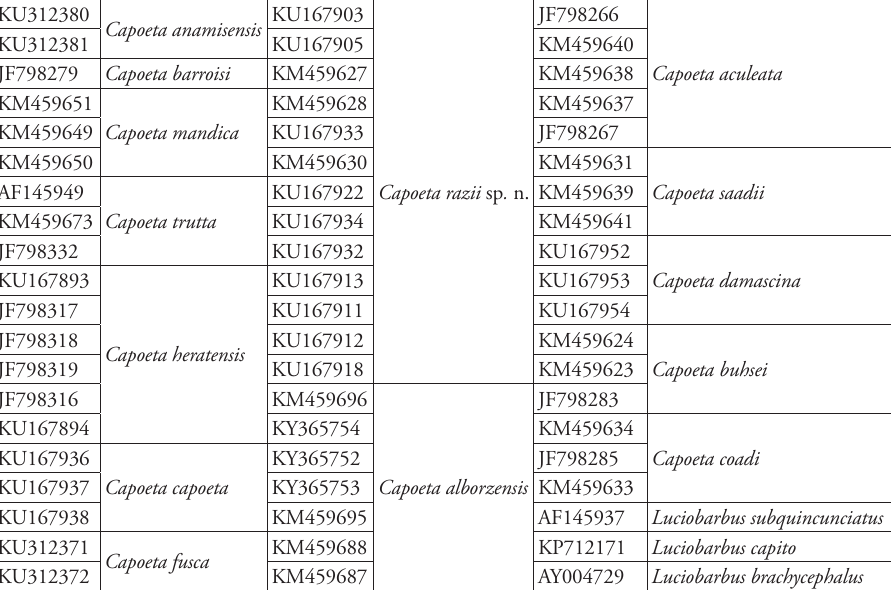
Table 2. List of species used for molecular analysis for Cyt b and GenBank accession number